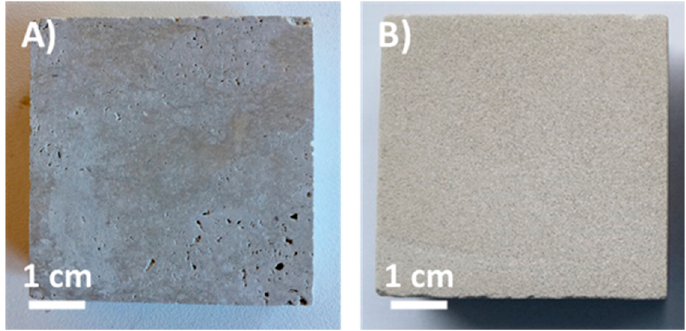
Figure 1. Photographs of Ajarte ( A ) and Obernkirchen ( B ) stone specimens.